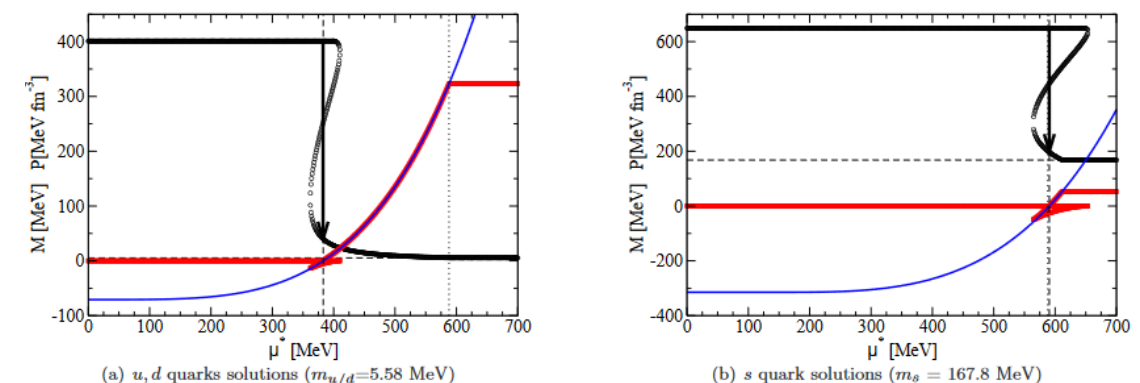
Figure 1. (color online) Single flavor dynamical masses (black) and corresponding pressure (red) computed within the NJL model. The latter is well fitted by the pressure of an ideal Fermi gas (with bare quark mass m f ) shifted by a chiral bag constant B χ (blue). Figure from [18].